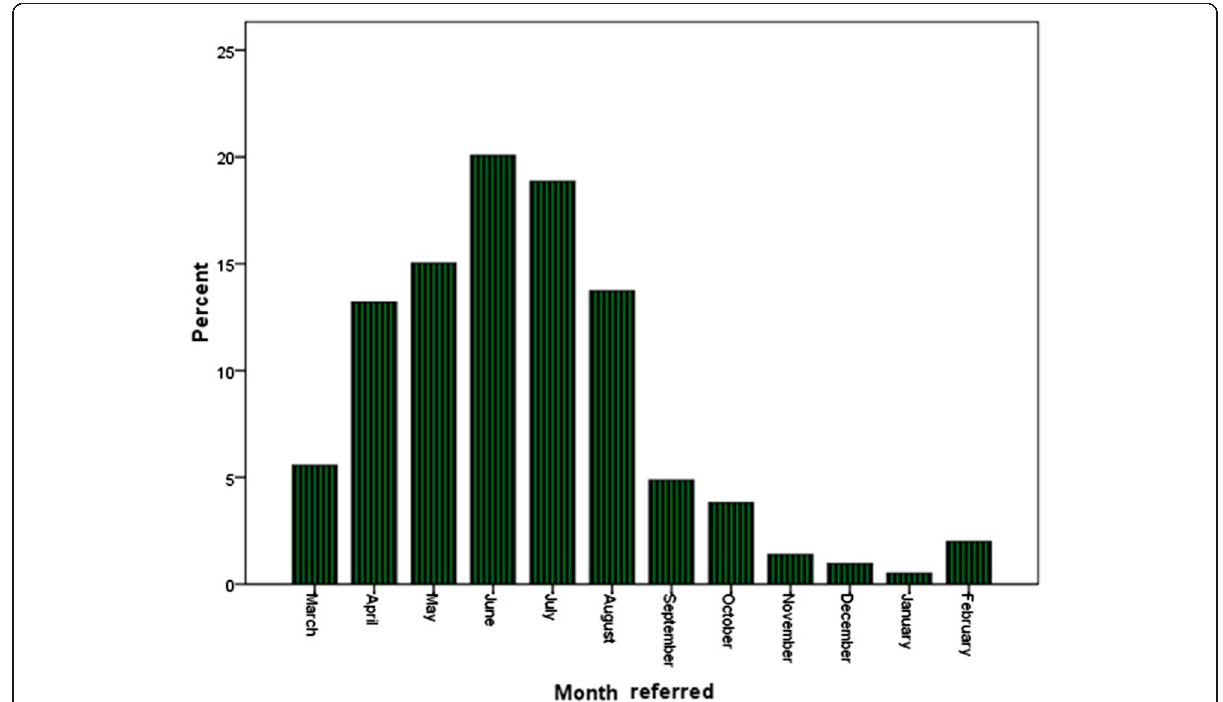
Fig. 2 Frequency percent of scorpion stings based on the months of the